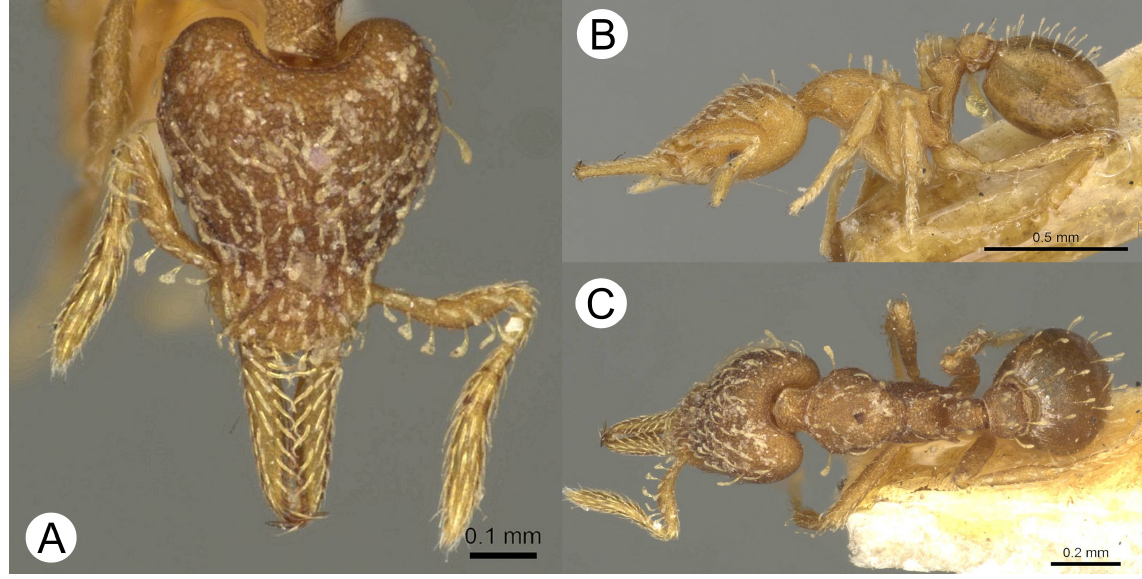
Fig. 7. Lectotype of Strumigenys subedentata Mayr, 1887 (CC-BY, CASENT0915703, Harald Bruckner, from www.antweb.org). A . Head, mandibles and antennae, in dorsal view. B . Full body, in lateral view. C . Full body, in dorsal